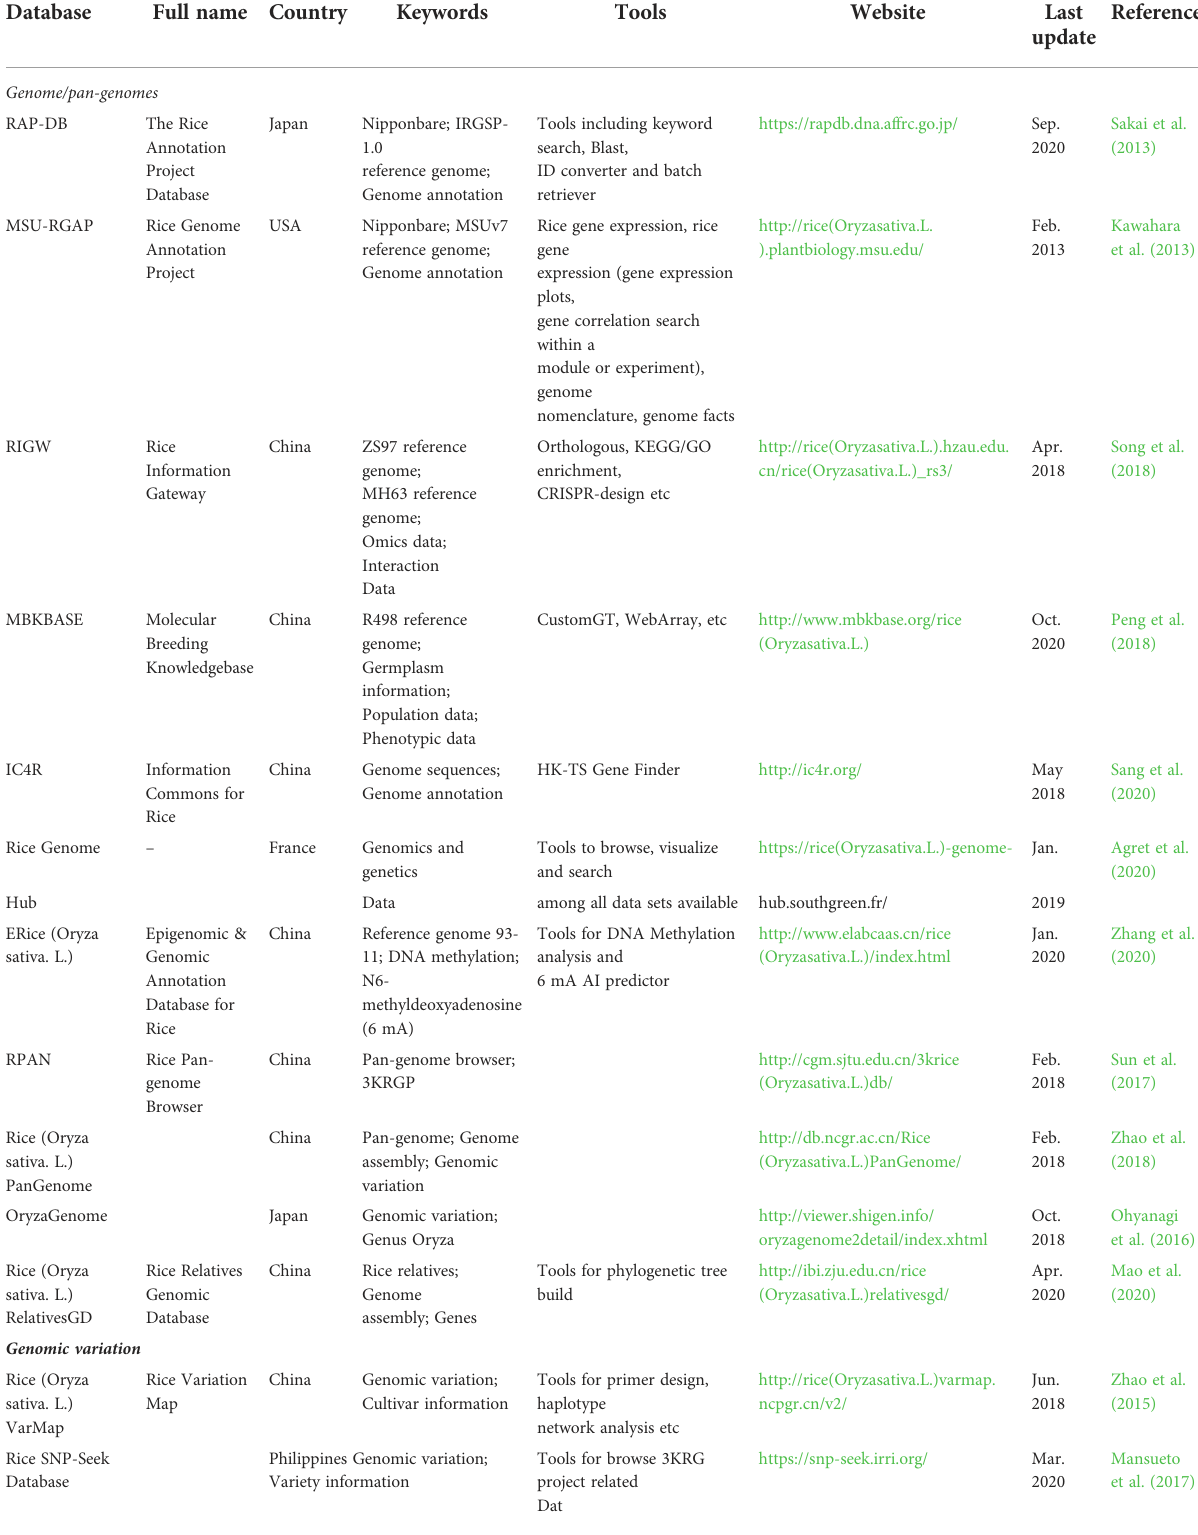
TABLE 4 List of resources for genomic and transcriptome databases of rice